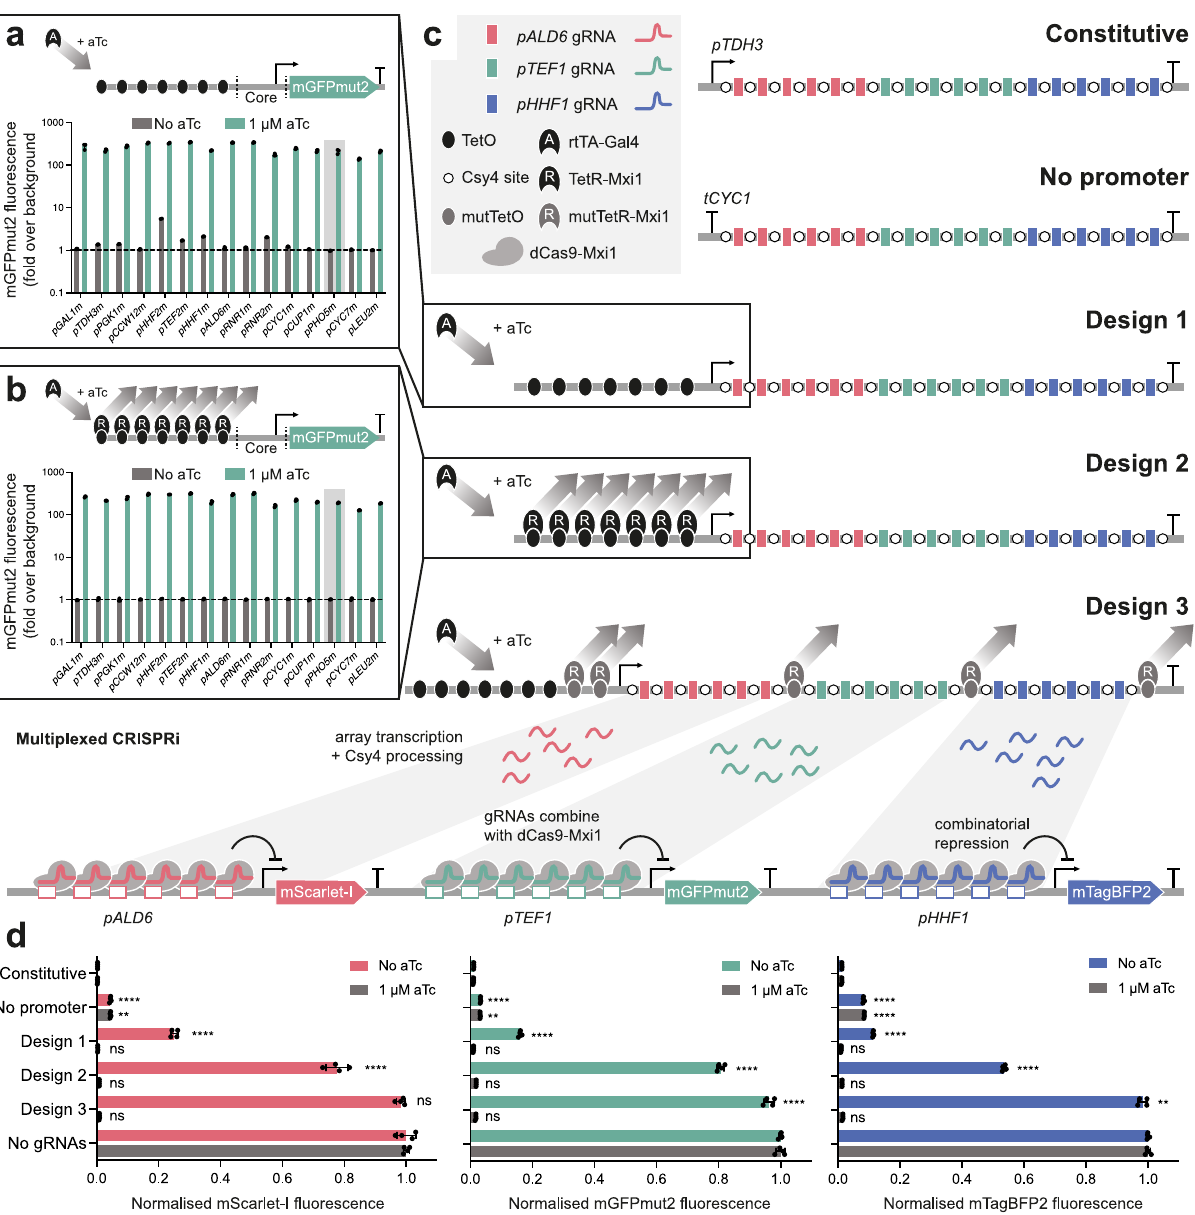
induciblegRNAarray,Design2. c Csy4processedgRNAarraysdrivenbythevarious expression systems. Arrays are composed of 18 gRNAs designed to target the constitutive yeast ALD6 , TEF1 , and HHF1 promoters driving the expression of mScarlet-I,mGFPmut2,andmTagBFP2,respectively,forrepressionbydCas9-Mxi1. d Fluorescence measurements of mScarlet-I, mGFPmut2, and mTagBFP2 in the presence and absence of 1 µ M aTc across the various gRNA array expression sys- tems, normalised to a no-gRNA and a no- fl uorescentproteincontrol.Experimental measurementsare fl uorescencelevelspercellasdeterminedby fl owcytometryand shown as the mean±SD from four biological replicates. Statistically signi fi cant differences between Constitutive (1 µ M) or No gRNA (No aTc) and all other condi- tionsweretestedby2-wayANOVA,andsigni fi cancelevelsareshownas p <0.01(**), and p <0.0001